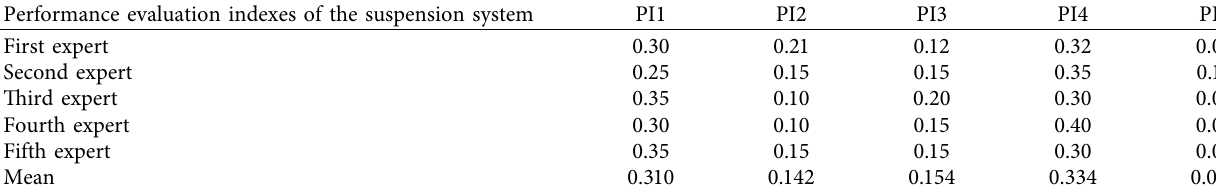
Table 2: The experts survey weight.